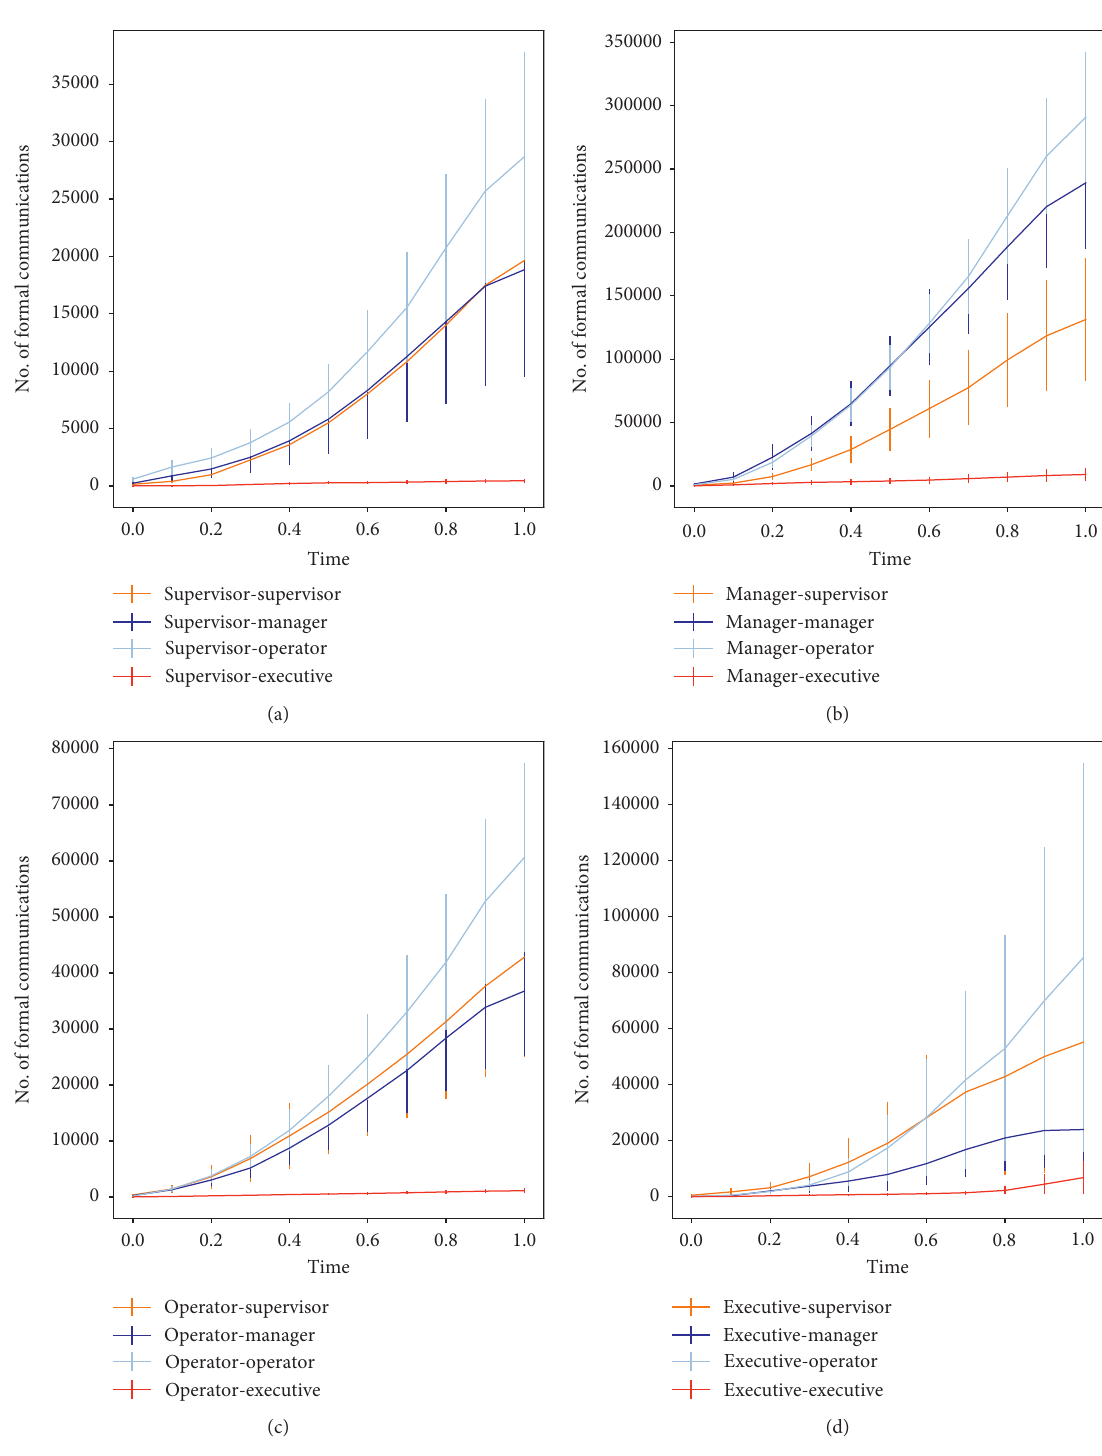
Figure 10: Average number of level-to-level communications of functional networks over time for all enterprises. (a–d) Communications originated by supervisors, managers, operators, and executives, respectively. Orange, blue, light blue, and red lines show communications directed to supervisors, managers, operators, and executives, respectively. Error bars indicate the standard deviation. An analogous plot for social communications is shown in Figure